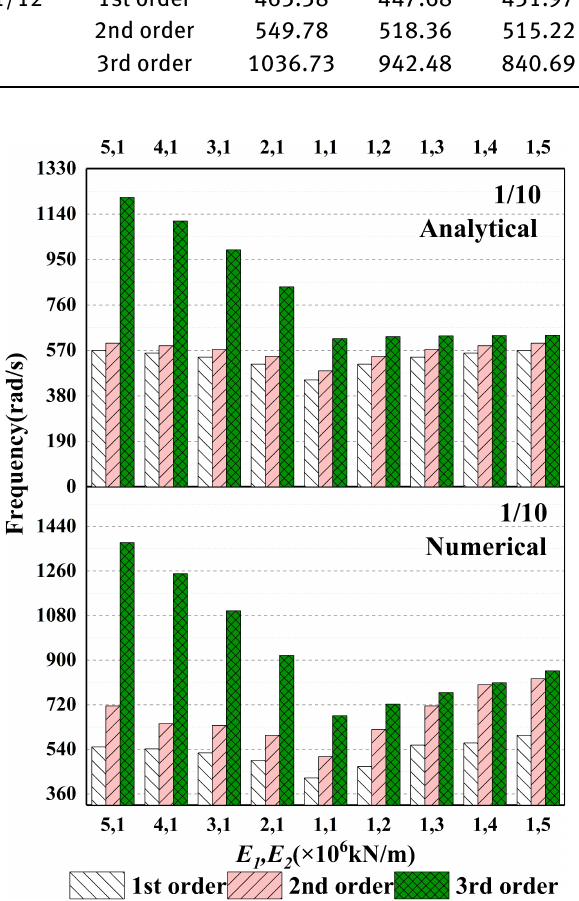
Figure 10: Comparison of natural frequencies under different elastic modulus ratios when the rise span ratio is